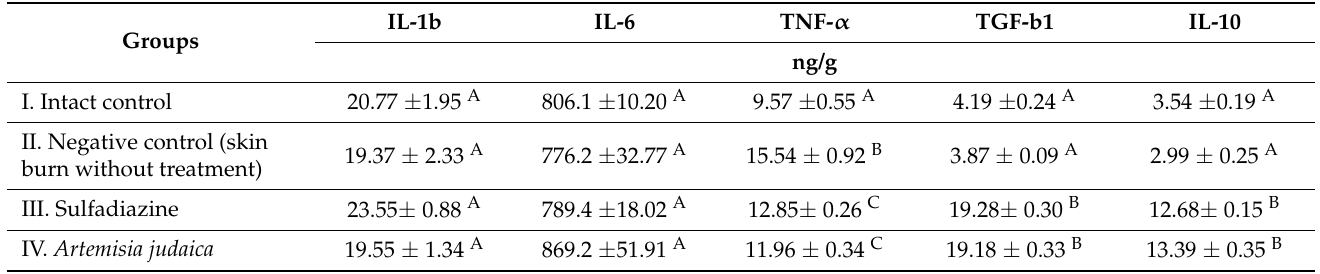
Table 6. Effect of Artemisia judaica ointment on inflammatory and pro-angiogenic markers in skin burn rat